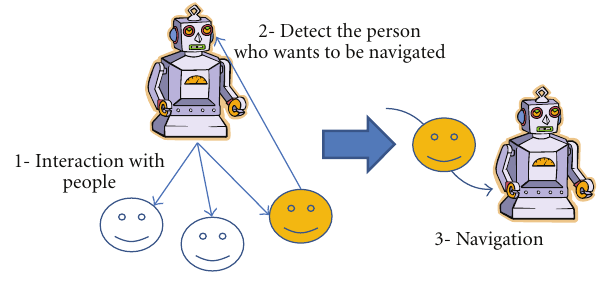
Figure 1: Our navigation robot